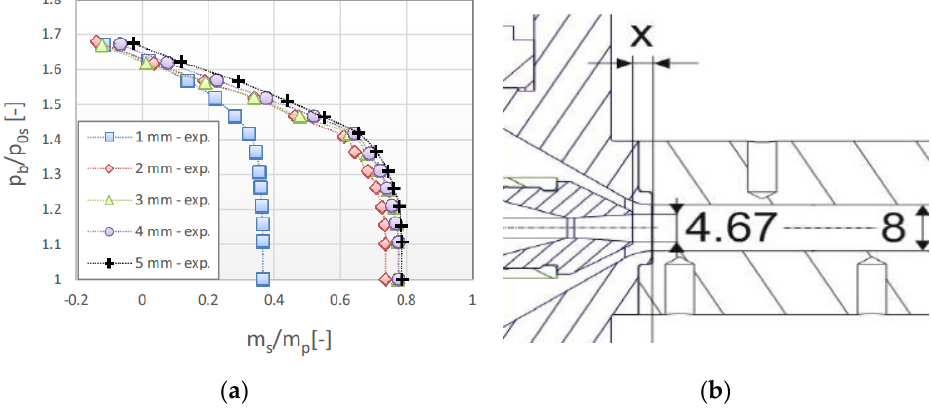
Figure 11. ( a ) are the velocity contour plots for oscillation at 5 Hz frequency at 2 o and 10 o angles, with inlet, suction and outlet pressure boundary conditions as 4.5 bar, 1 bar and 1 bar, respectively. It shows that velocity waves transport along with the axial plane of the system. ( b ) the plot for varying frequency at different oscillation angles. Experimental observation of performance for different nozzle positioning [64].